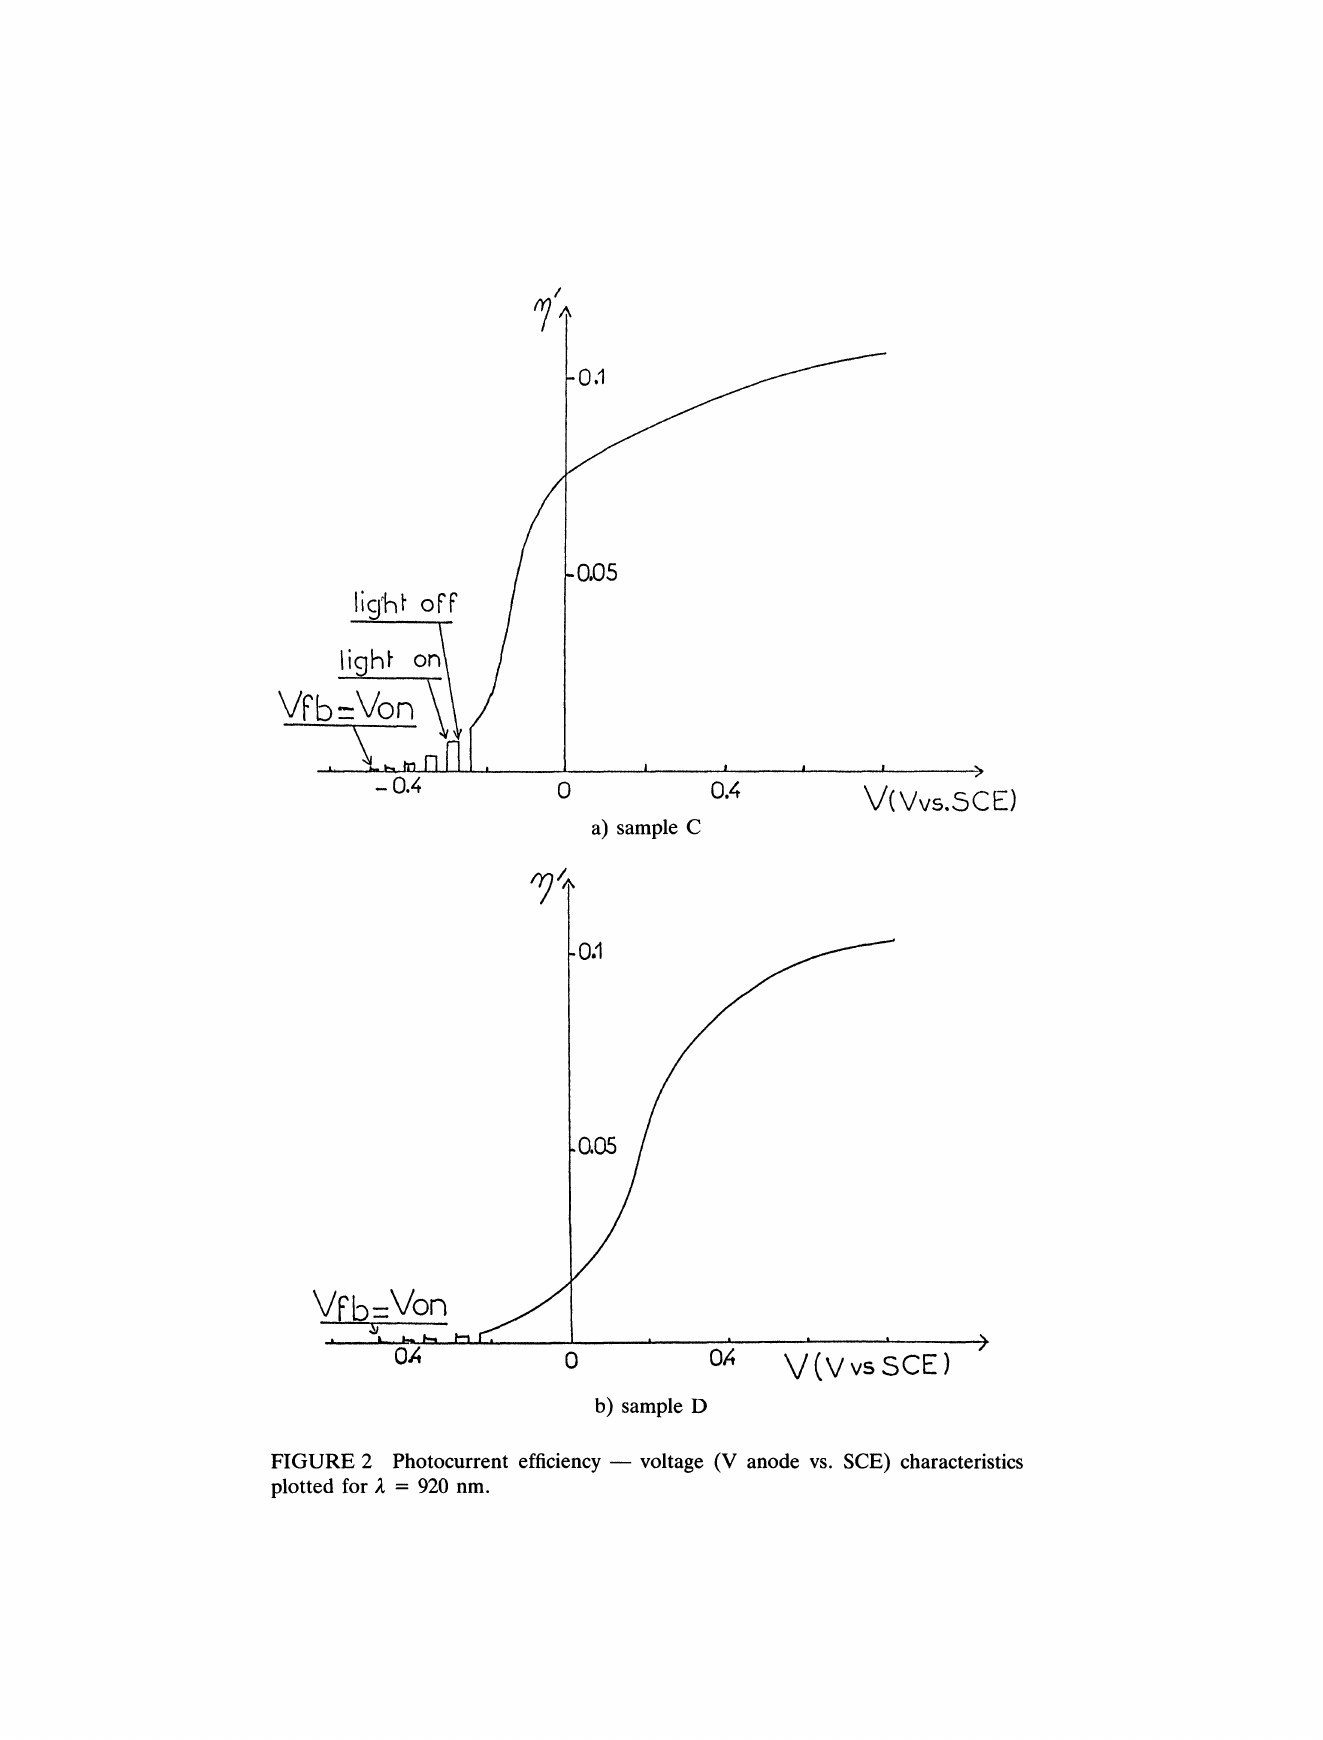
FIGURE 2 Photocurrent efficiency voltage (V anode vs. SCE) characteristics plotted for 2 920